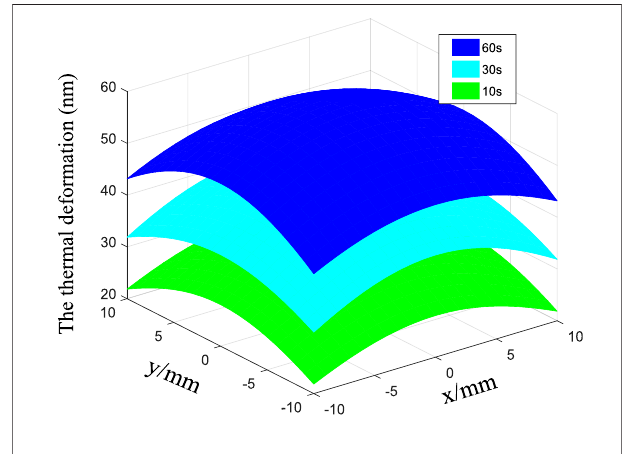
FIGURE 11 | In fl uence of different irradiation times on the thermal